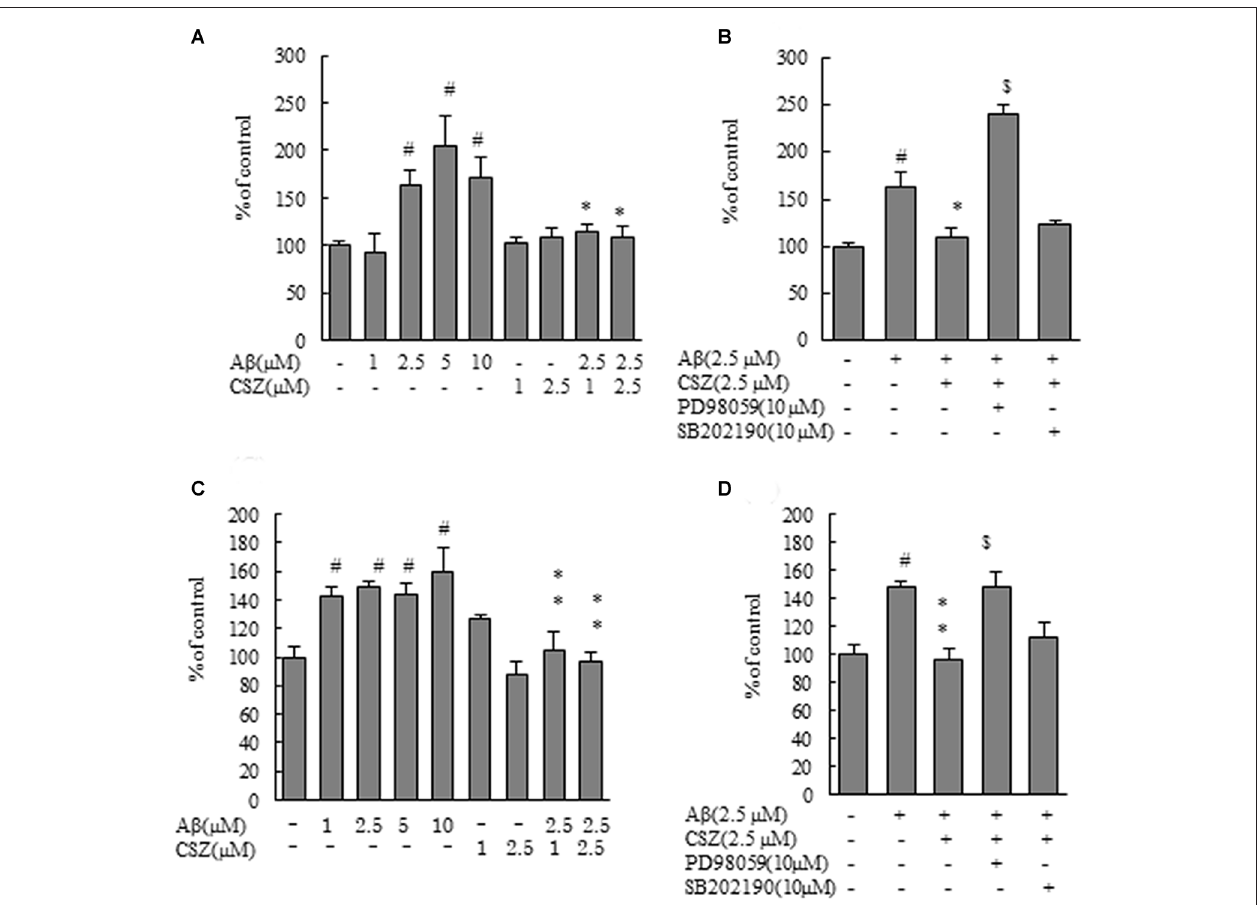
FIGURE 2 | Effects of CSZ on caspase-3 and -9 activitives in A β -stimulated SH-SY5Y cells. Caspase-3 and -9 activities were measured using each peptide substrate (DEVD-AFC and LEHD-AFC). (A) Caspase-3 activity in SH-SY5Y cells treated with A β (1–10 µ M) or CSZ (1, 2.5 µ M) for 20 h. (B) Caspase-3 activity was determined in SH-SY5Y cells incubated with or without 1 h pretreatment with CSZ or inhibitor of MEK1/2 or p38 MAPK followed by 20 h incubation with A β . Caspase-3 activity of the control cells was 60.54 ± 4.35 nmol/mg protein/h. (C) Caspase-9 activity in SH-SY5Y cells treated with A β (1–10 µ M) or CSZ (1, 2.5 µ M) for 20 h. (D) Caspase-9 activity was determined in SH-SY5Y cells incubated with or without 1 h pretreatment with CSZ or inhibitor of MEK1/2 or p38 MAPK followed by 20 h incubation with A β . Caspase-9 activity of the control cells was 25.72 ± 3.2 nmol/mg protein/h. Values are expressed as mean + SEM. # Compared vs. respective controls ( p < 0.01). ∗ Compared vs. A β -treated cells ( p < 0.05). ∗∗ Compared vs. A β -treated cells ( p < 0.01). $ Compared vs. A β + CSZ-treated cells ( p <